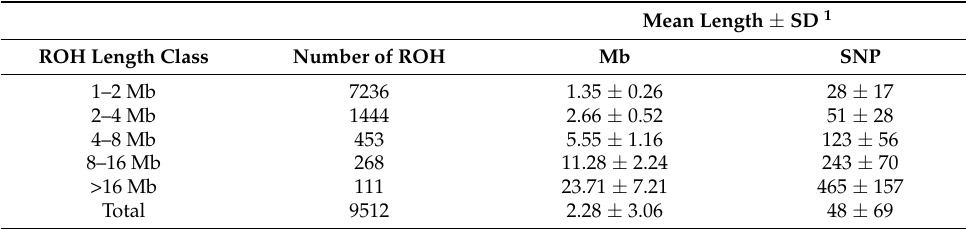
Table 3. Number and mean length [in Mb and number of single-nucleotide polymorphisms (SNP)] of runs of homozygosity (ROH) in different length classes.